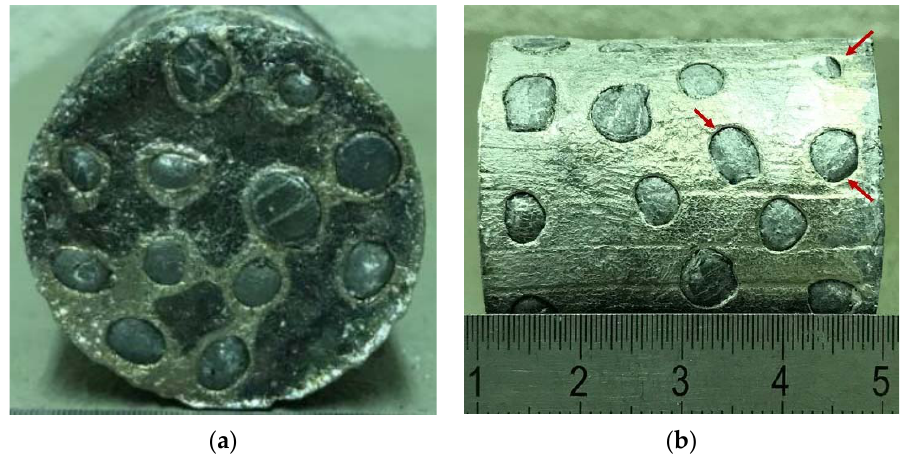
Figure 4. Sample of as-cast Al-EAn, ( a ) base and ( b ) profile.